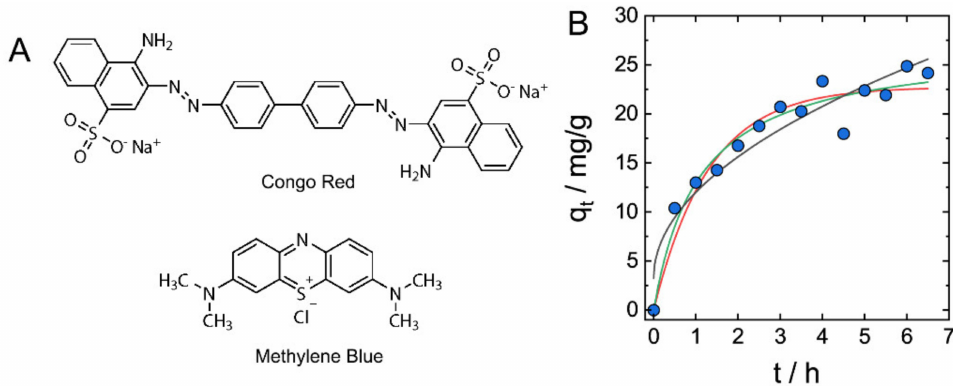
Figure 3. Adsorption of cationic and anionic dyes by DNA–CS hydrogels. ( A ). Chemical structure of Congo Red and Methylene Blue. ( B ). Kinetics of Methylene Blue absorption by DNA–CS hydrogel. Lines are fitting to pseudo-first-order (red), pseudo-second-order (green), and interparticle diffusion (black) kinetics